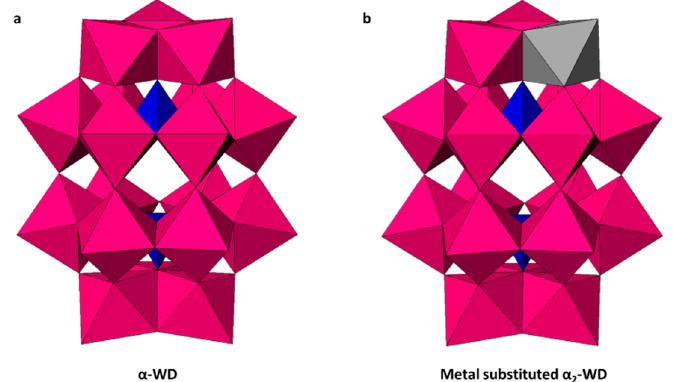
Figure 1. Illustrations of ( a ) the α -Wells–Dawson polyoxometalate (POM) [P 2 W 18 O 62 ] 6 − ( α -WD) and ( b ) the metal-substituted α 2 -Wells–Dawson (WD) species with the substituted metal shown in grey, MO 6 , in pink and XO 4 in blue.